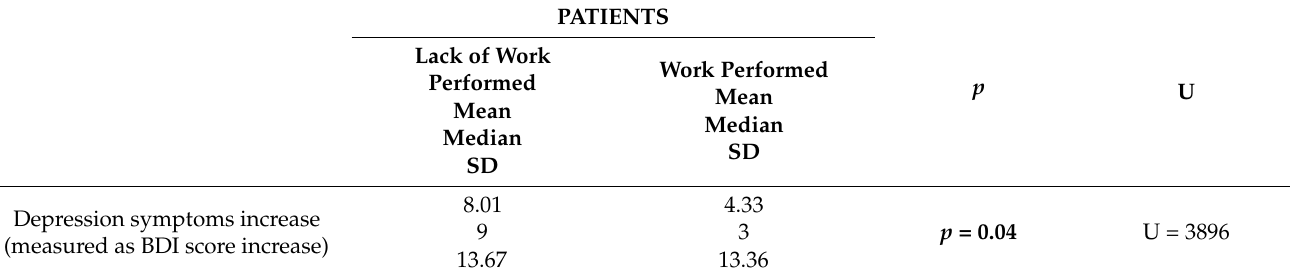
Table 3. Increase of BDI from pre-pandemic to current (during pandemic) period of time among patients depending on their job status. Mann-Whitney U test.